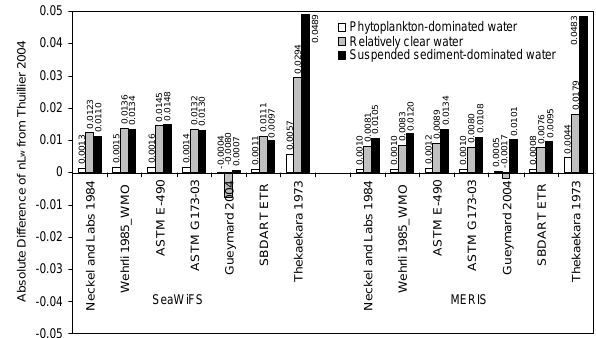
Fig. 8. The band-averaged nL w differences between the Thuillier 2004 and other spectra in three cases of the waters.